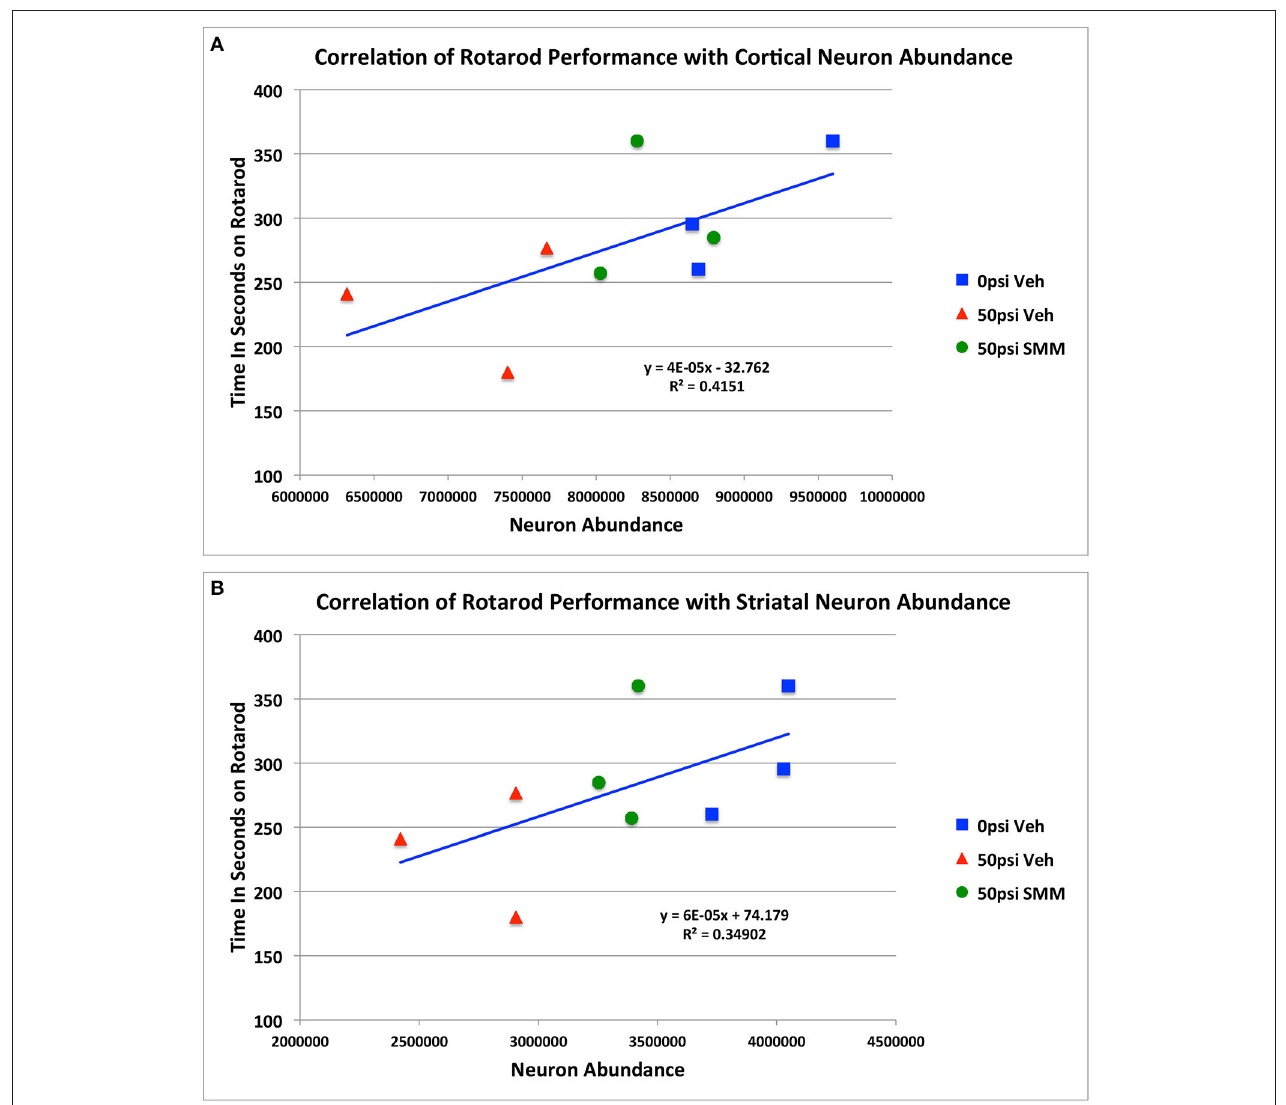
FIGURE 5 | Regression analysis showing the relationship between rotarod performance and the extent of cortical (A) and striatal (B) neuronal loss and rescue, combining the data for all three groups of mice.